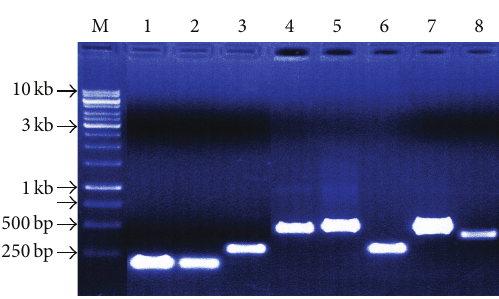
Figure 1: Gel purified PCR product of the field isolated mushroom samples (M marker lane, 1kb